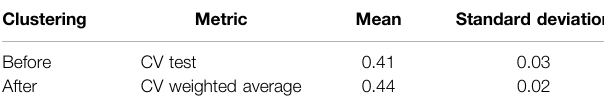
TABLE 5 | Cold start problem and